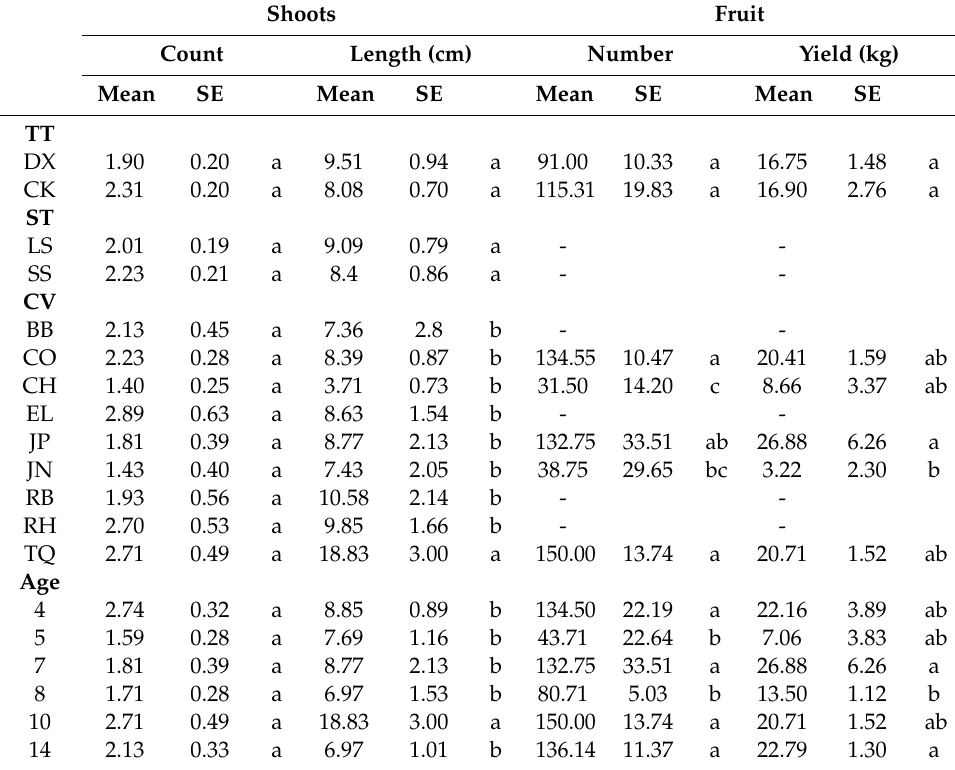
z Statistical output and F values indicating probability of significance were in Table S3. The count and average length (cm) of the year-end new shoots grown on flagged shoots were performed on Oct 26, 2017. The fruit number and yield (kg) from unthinned Dormex-sprayed and unsprayed trees were collected in the following season (2018). Means with the same letter are not significantly di ff erent ( α = 0.05). TT = treatment; DX = Dormex sprayed; CK = unsprayed control; ST = shoot type; LS = long shoot; SS = short shoot; CV = cultivar; BB =